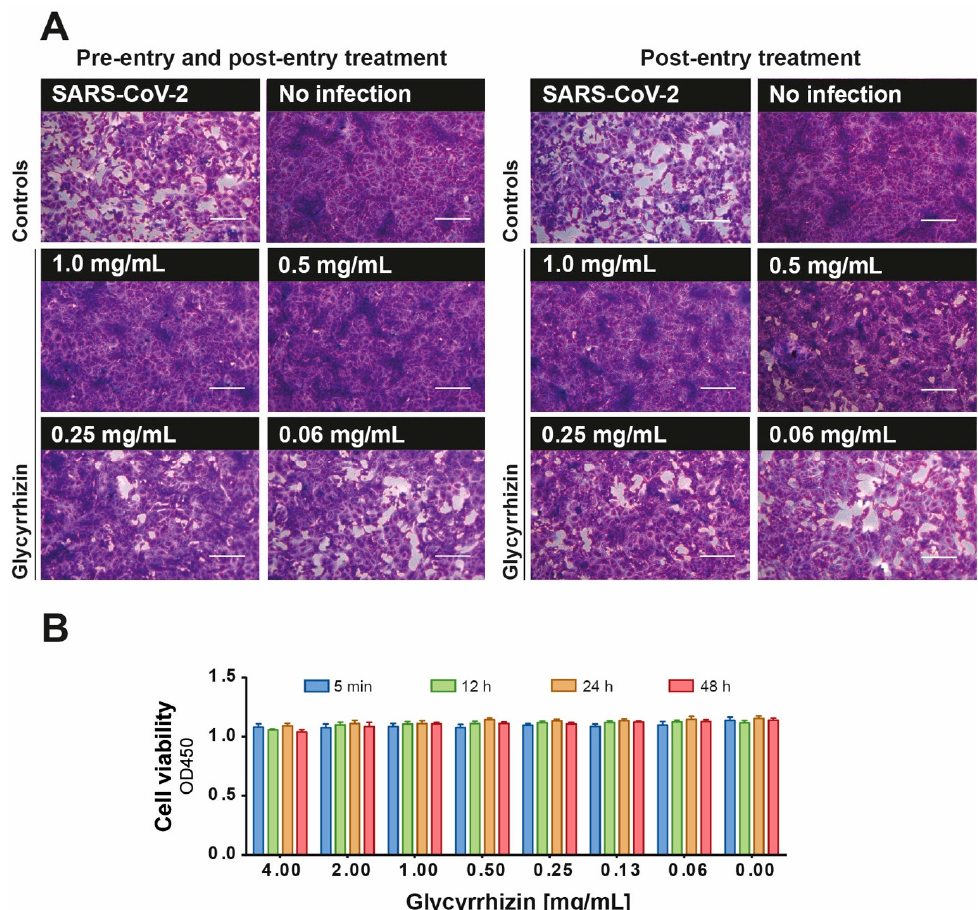
Figure 3. Antiviral efficacy of glycyrrhizin against SARS-CoV-2. The antiviral efficacy of glycyrrhizin against SARS-CoV-2 was investigated under combined pre- and post-entry or post-entry conditions. ( A ) Descending concentrations of glycyrrhizin (0.002–4 mg/mL) were pre-incubated with 100 TCID 50 SARS-CoV-2 for 1 h at 37 °C and subsequently added to confluent Vero E6 cells in 96-well microtiter plates for 48 h (combined pre- and post-entry conditions). In a second ap- proach, Vero E6 cells were inoculated with 100 TCID 50 SARS-CoV-2 for 4 h before the glycyrrhizin-containing inoculation medium with various glycyrrhizin concentrations (0.002–4 mg/mL end-concentration) was added (post-entry conditions). Plaque formation was evaluated after 48 h post infection (p.i.). Bars represent 200 μ m. ( B ) Cytotoxicity of glycyrrhizin used at the indicated concentrations towards Vero E6 cells was tested using “Orangu cell counting solution”. Different concentrations of glycyrrhizin were incubated with a confluent layer of Vero E6 cells and the cell viability was evaluated at four different time points (5 min, 12 h, 24 h, 48 h). All experiments were performed in biological replicates. Error bars represent the standard error of the mean (SEM).